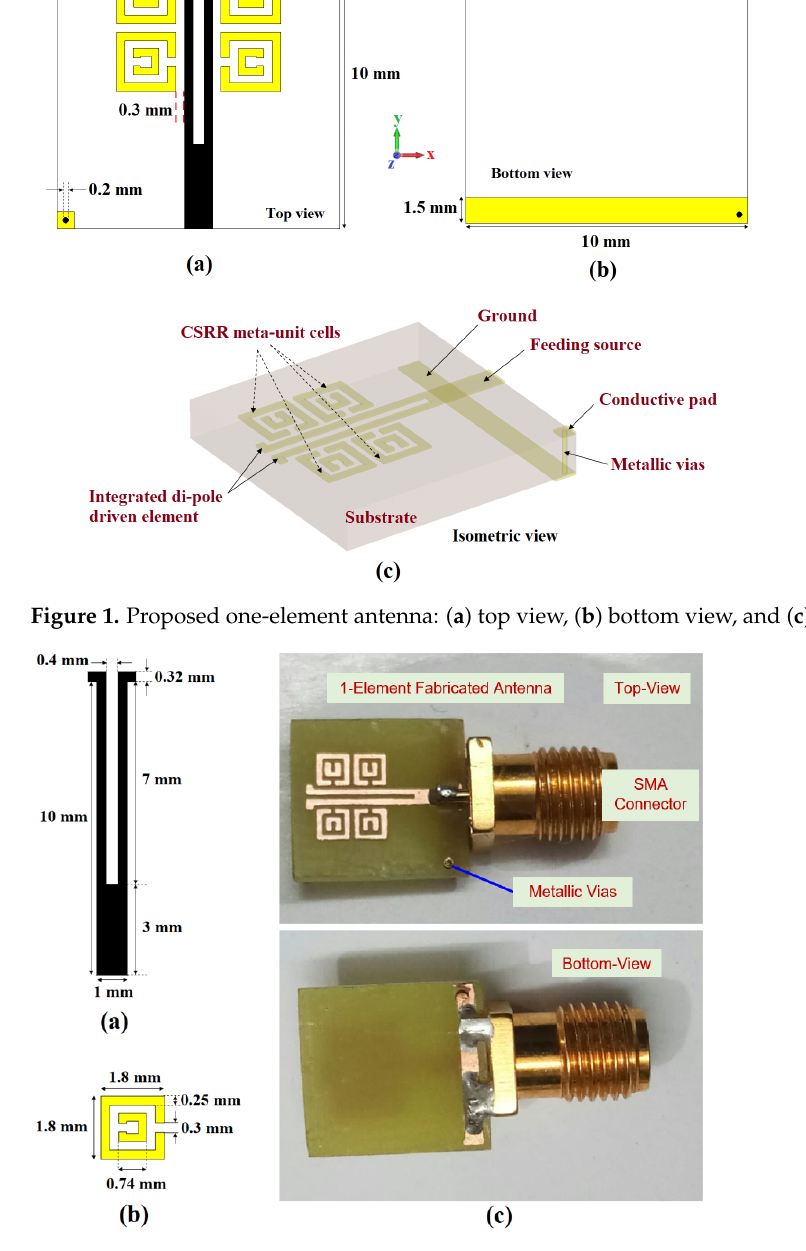
Figure 2. Fabricated prototype with schematics: ( a ) dipole feed, ( b ) meta-coupler, and ( c ) one- element